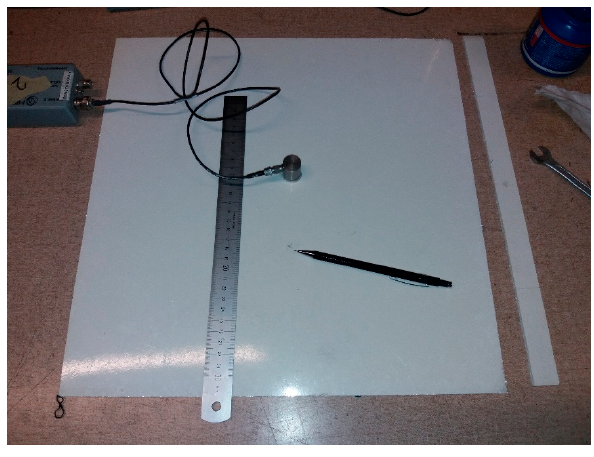
Figure 2 . The TRC plate (400 × 400 mm 2 , left) and beam (400 × 20 mm 2 , right). Figure 2. The TRC plate (400 × 400 mm 2 , left ) and beam (400 × 20 mm 2 , right